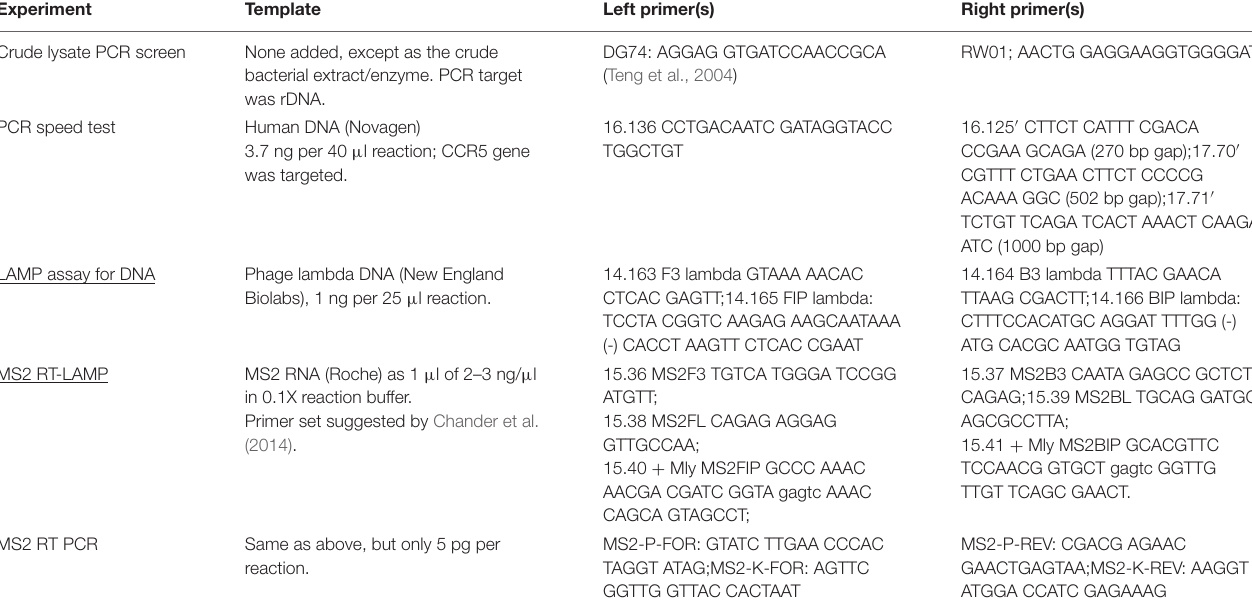
TABLE 2 | Templates and primers. Experiment Template Left primer(s) Right primer(s) Crude lysate PCR screen None added, except as the crude bacterial extract/enzyme. PCR